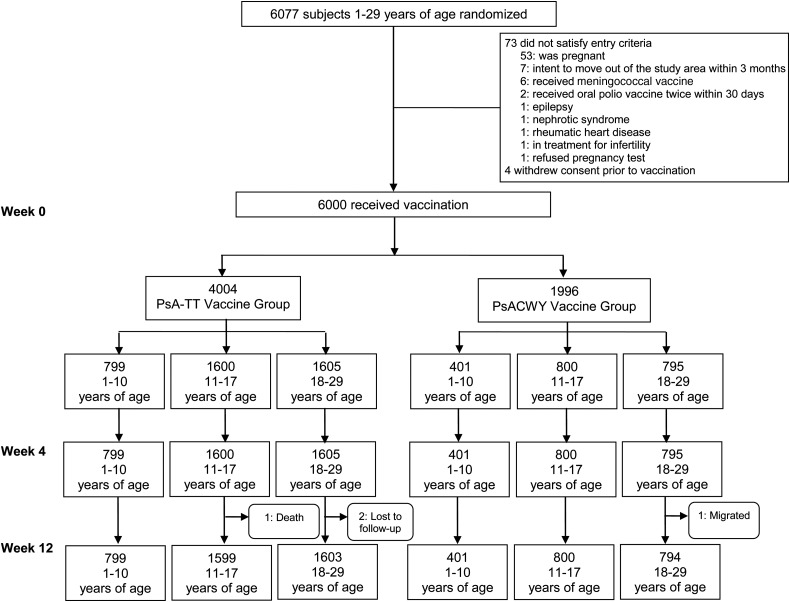
Study population. Abbreviations: PsACWY, group A, C, W, Y meningococcal polysaccharide vaccine; PsA-TT, group A meningococcal polysaccharide-tetanus toxoid conjugate vaccine.